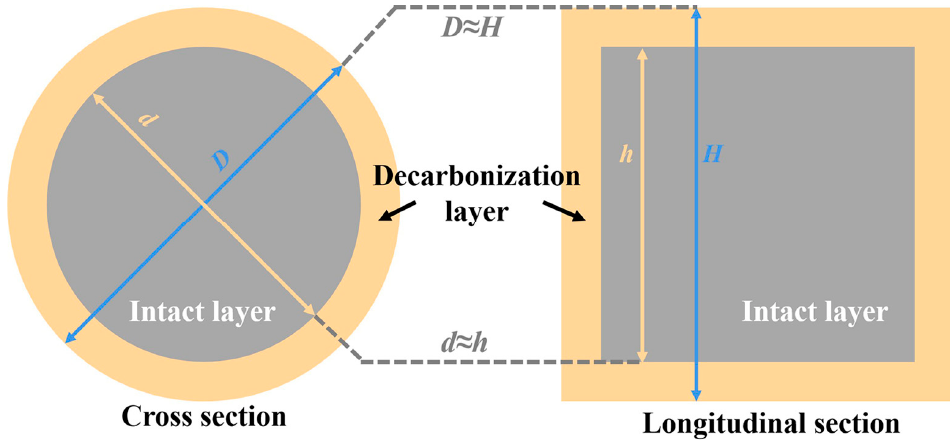
Figure 1. The theoretical profile of the oxidized sample.